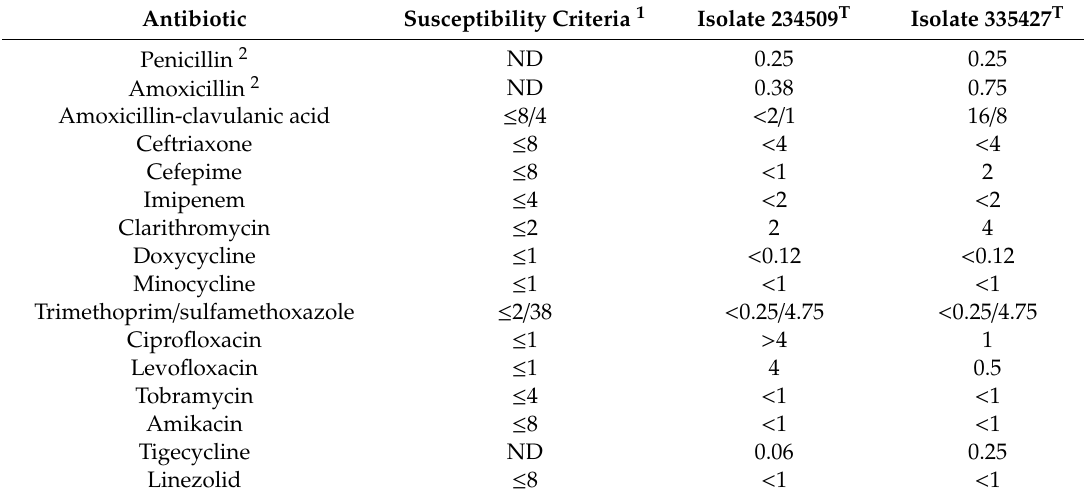
Table 3. Antimicrobial MIC of isolates 234509 T and 335427 T against 16 antibiotics determined by broth microdilution and